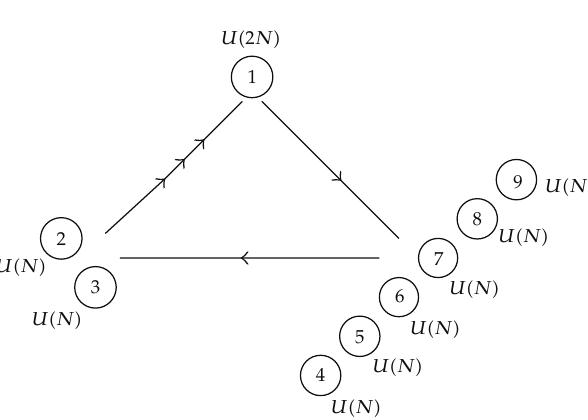
Figure 2: Quiver gauge theory for the cone over dP 6 .